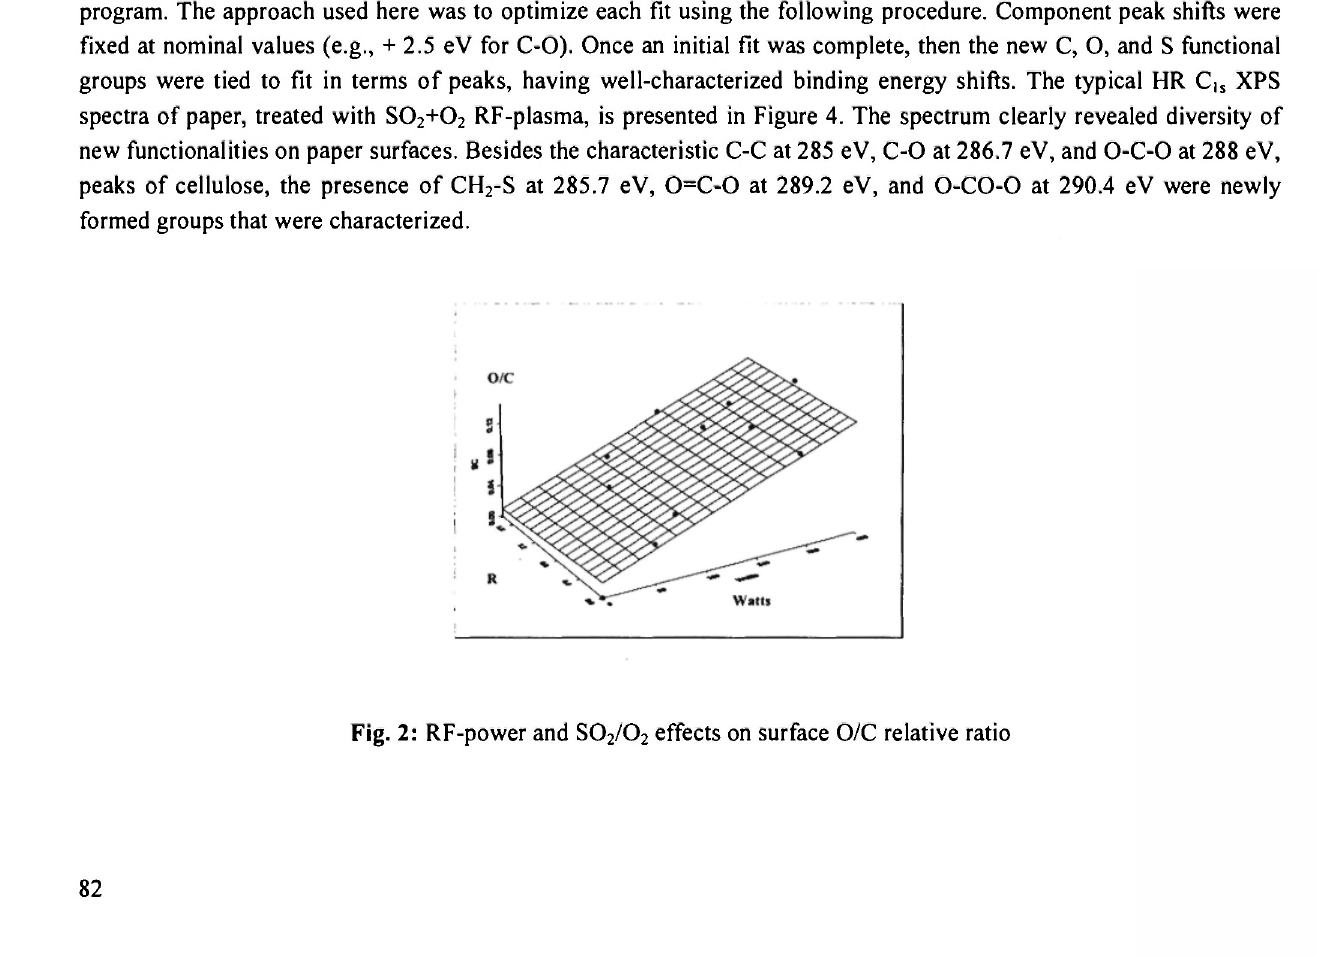
Fig. 2: RF-power and S0 2 /0 2 effects on surface O/C relative